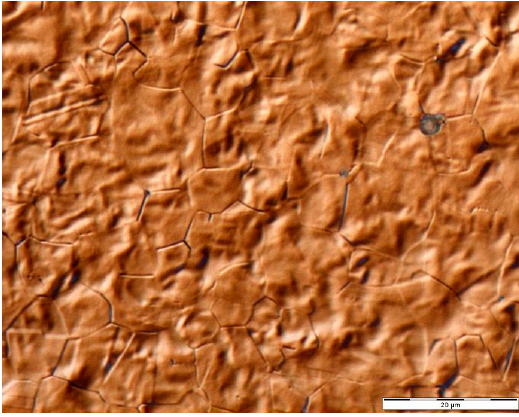
Figure 2. Microstructure after electrolytic etching in 10 wt.% oxalic acid.